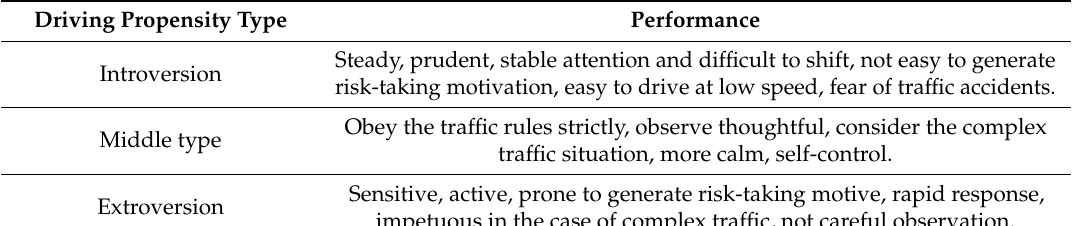
Table 1. Drivers’ driving propensity type and their